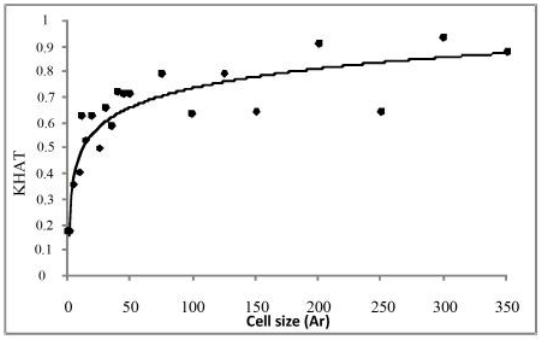
Figure 7. KHAT coefficient of all canopy density maps.